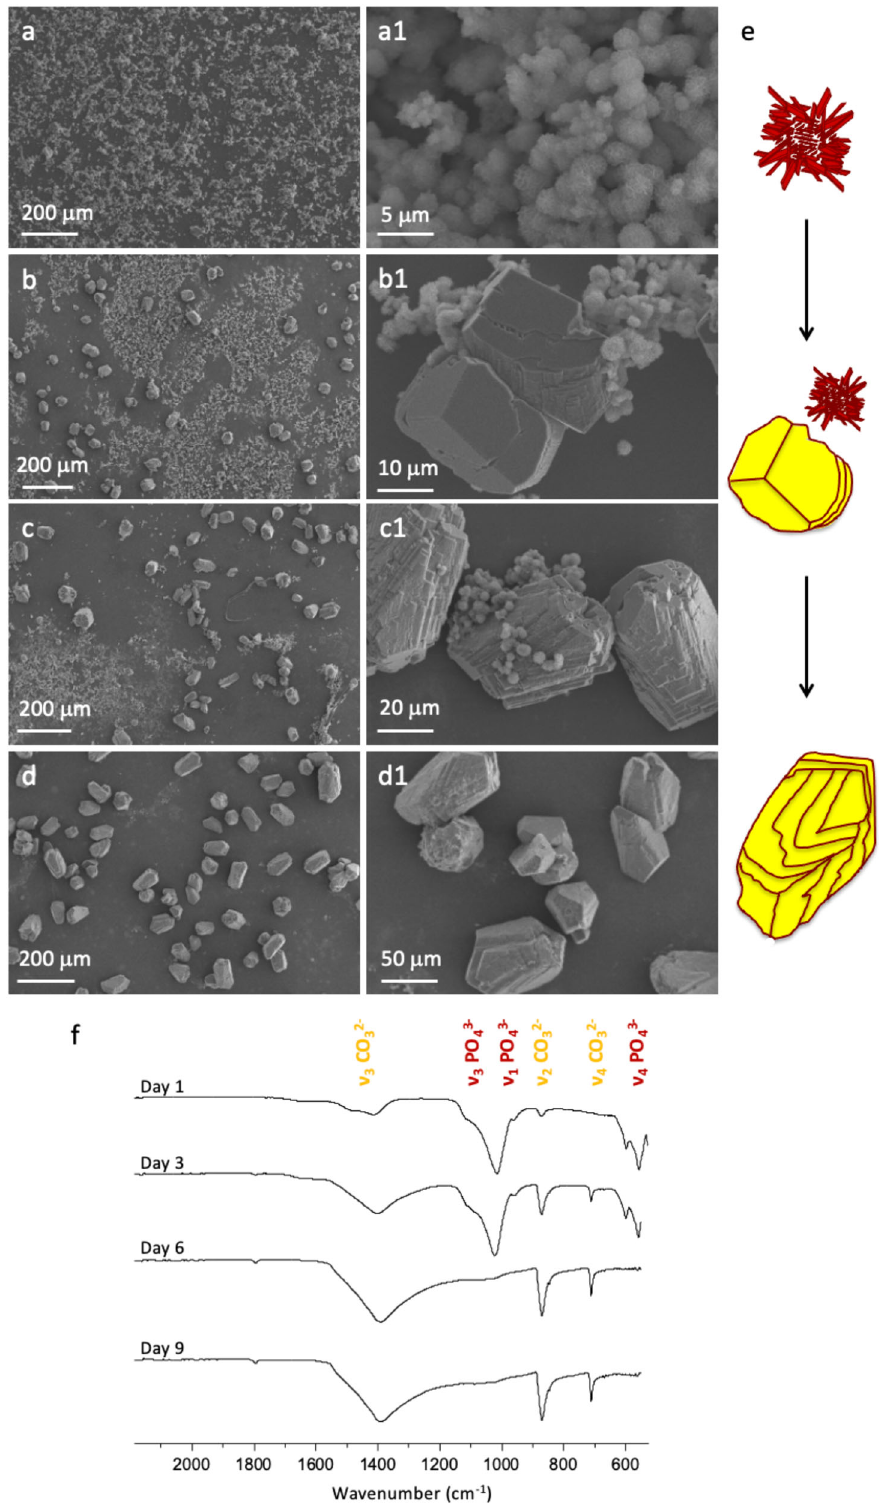
Fig. 5 Temporal evolution of minerals formed in the presence of inorganic phosphate with Ca/P = 3. SEM images show the minerals formed after 1 day ( a – a1 ), 3 days ( b – b1 ), 6 days ( c – c1 ), and 9 days ( d – d1 ). The schematic representation of apatite evolution towards calcite with eroded surfaces is showed in ( e ). FTIR spectra of minerals formed after different reaction time ( f ).